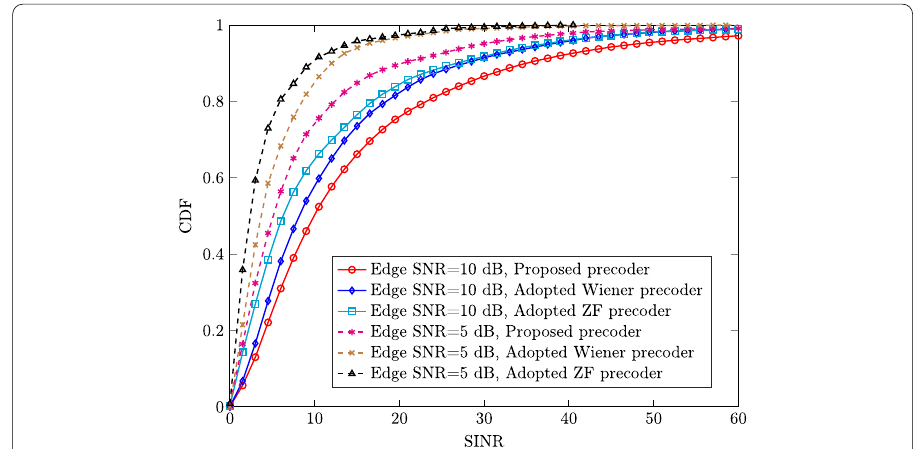
Fig. 7 CDF comparison of the proposed precoder with adopted ZF and Wiener precoders in terms of the users’ SINR. The channel is time-variant and r fl = r bl = 0.11 , N t = 1,N r = 1 , (cid:31) t = 1 ms and v = 5 km /